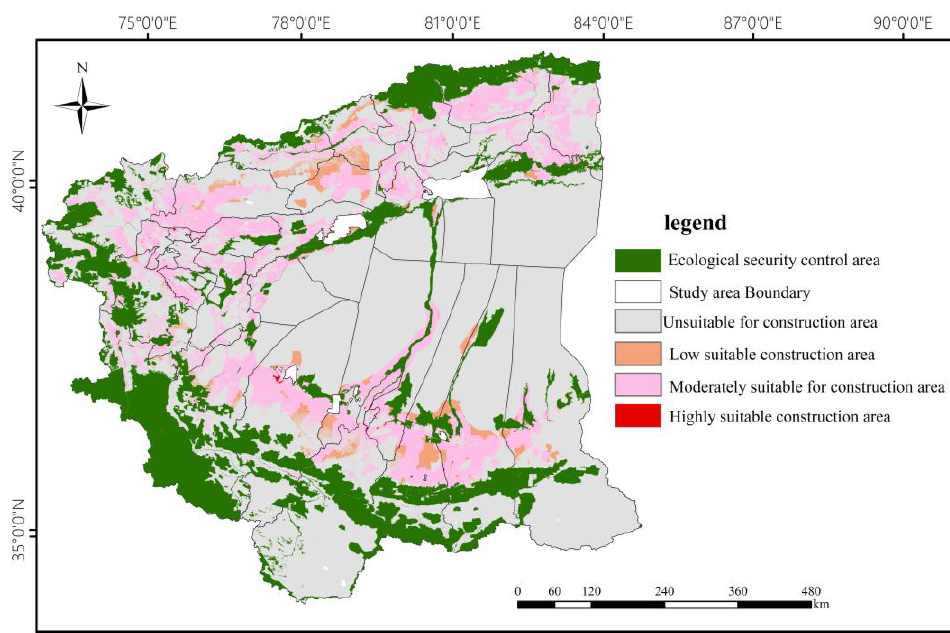
Figure 3. Comprehensive map of construction land suitability evaluation in the four southern Xinjiang